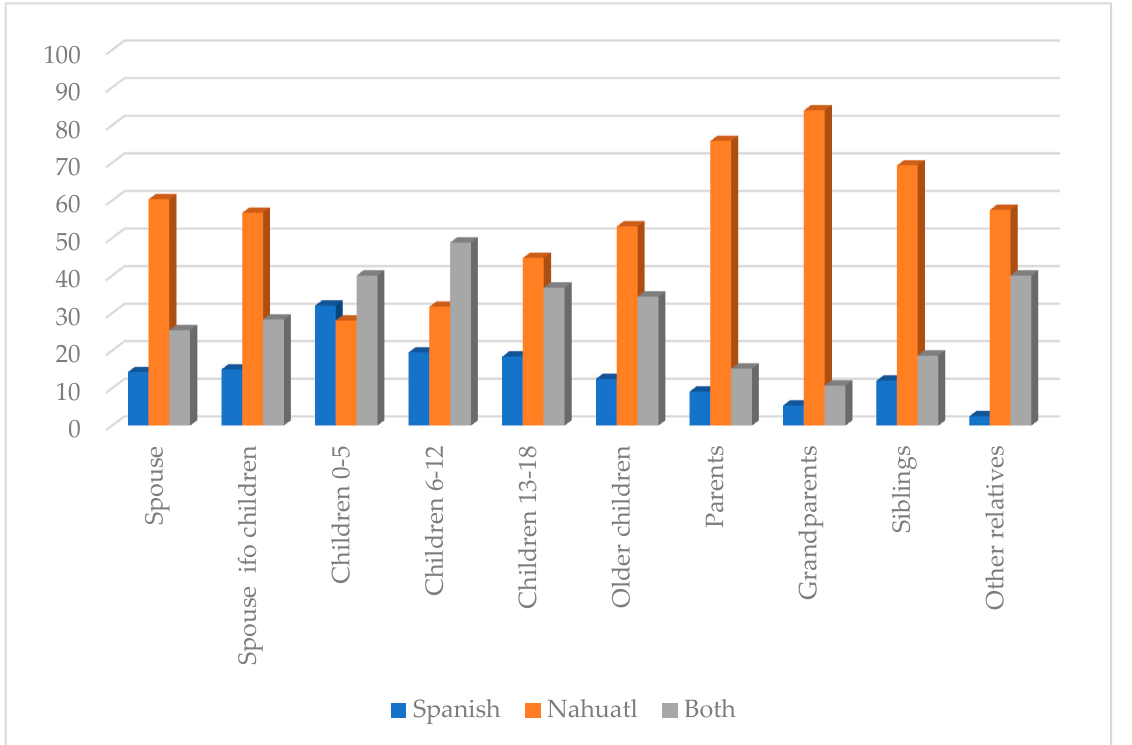
Figure 3. Language use at home by adults (in percentages).